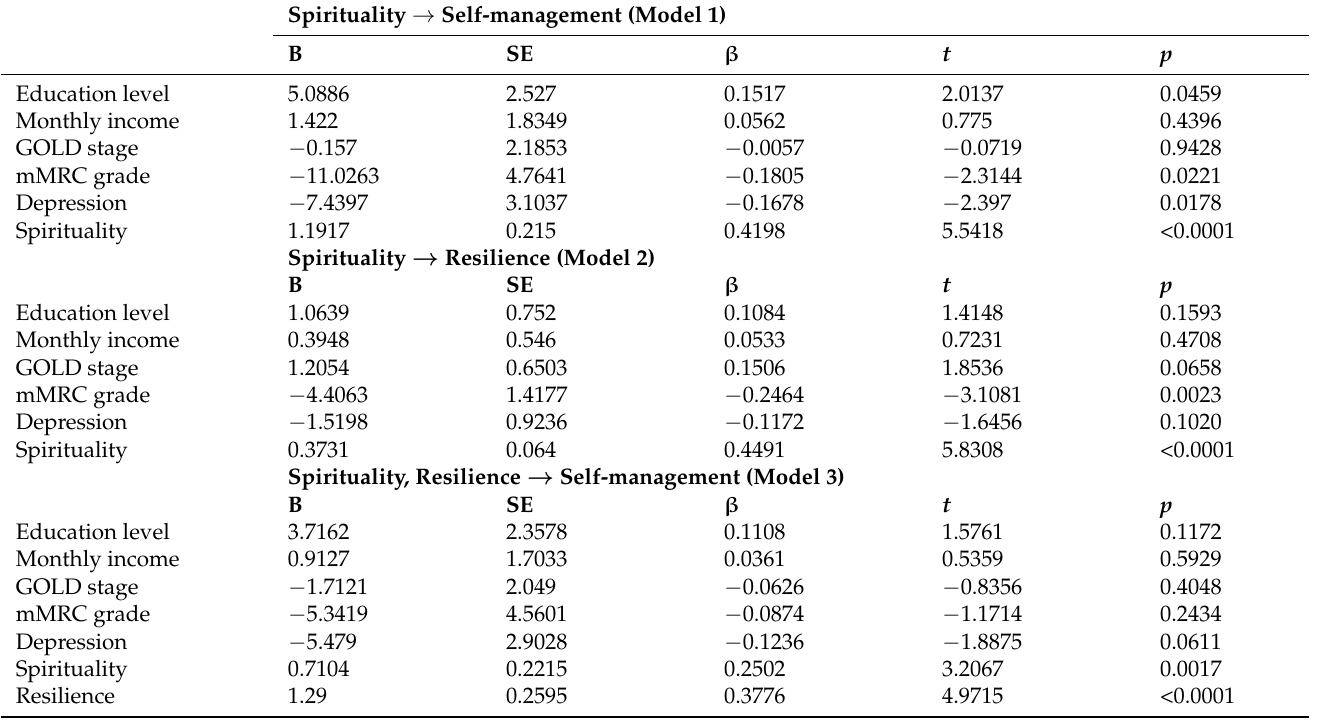
Table 5. Mediating effects of resilience on the relationship between spirituality and